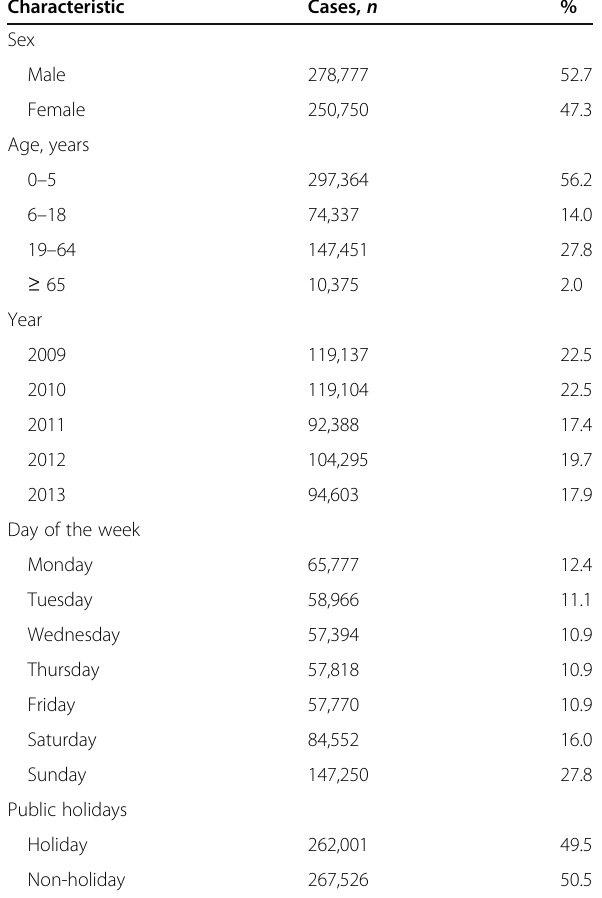
Table 1 Daily emergency room visits for acute upper respiratory tract infections according to several characteristics in Seoul, Korea, 2009 to 2013 ( n = 529,527) Characteristic Cases,